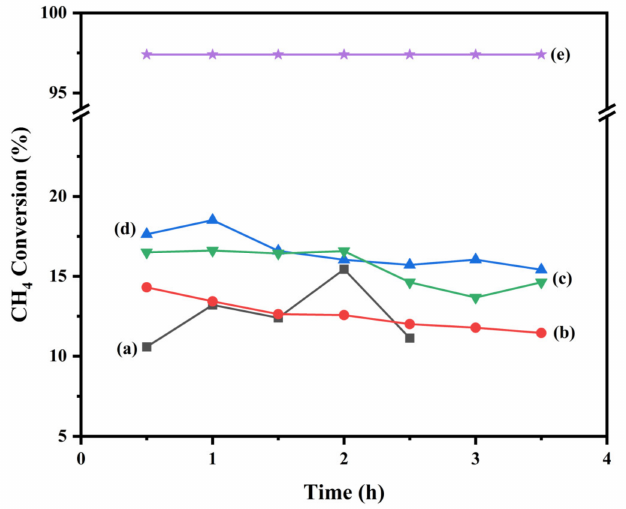
Figure 2. CH 4 Conversion of catalysts: ( a ) NaCl-KCl; ( b ) 2 g Ni/NaCl-KCl; ( c ) 20 g Ni/NaCl-KCl; ( d ) 10 g Ni/NaCl-KCl; and ( e ) equilibrium conversion. (Conditions: 99.9% 100 sccm CH 4 ; 900 ◦ C; 20 ppi Ni foam; 150 g